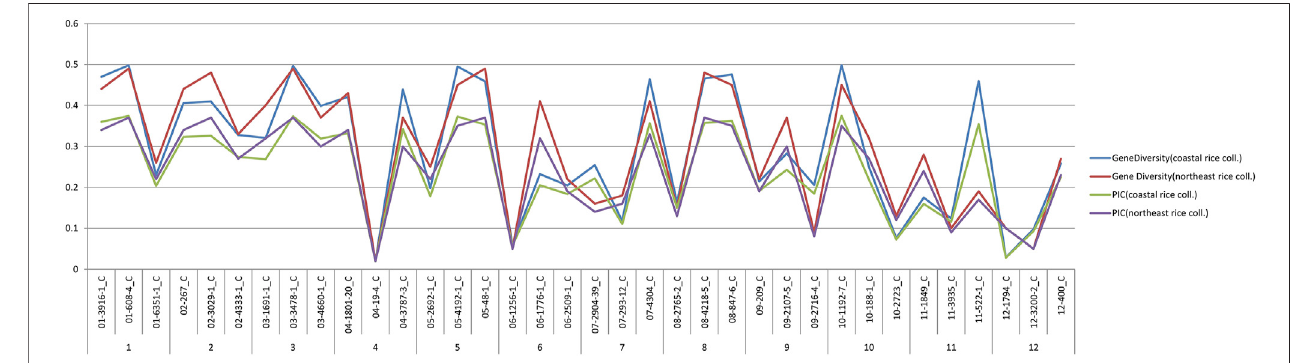
FIGURE 10 | Comparison of gene diversity and PIC of east coast rice and northeast rice